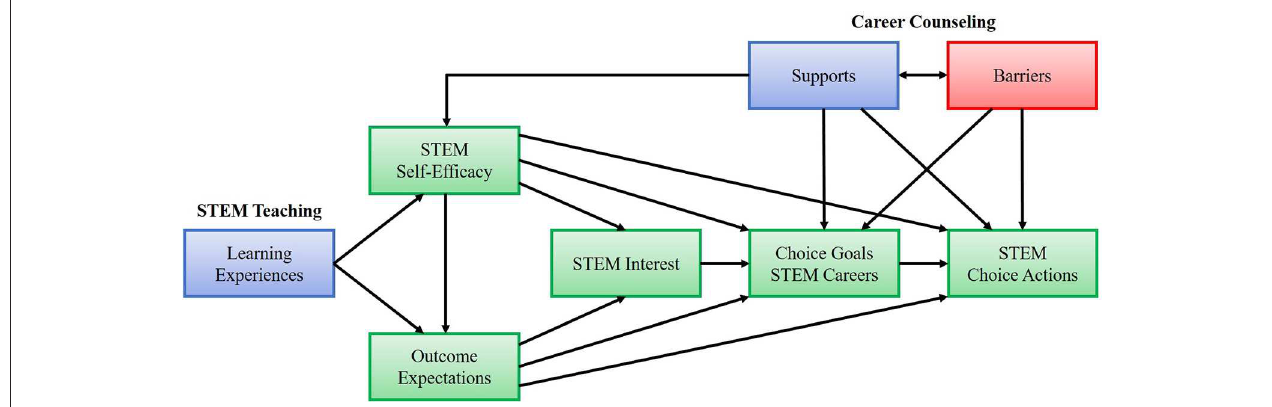
FIGURE 1 | Social Cognitive Career Theory: Interest and Choice